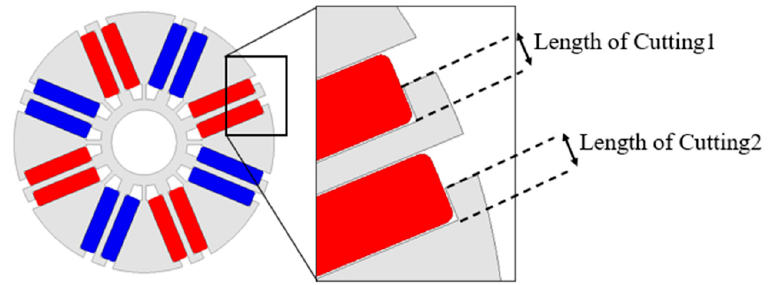
Figure 5. Concept diagram of core skew.